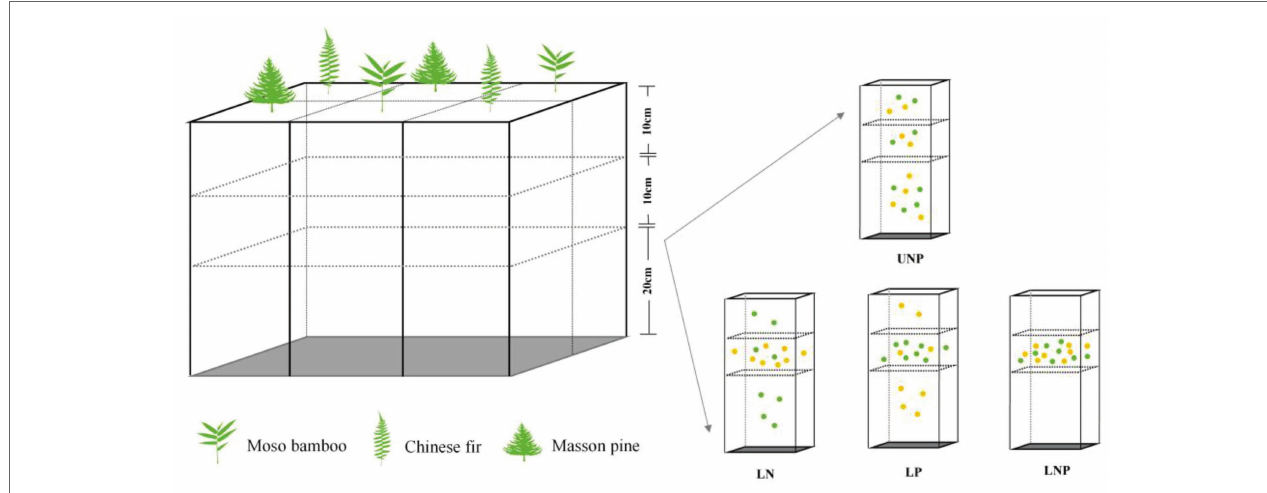
FIGURE 1 | Schematic drawing of the container and the experimental treatments. Each treatment was repeated six times (i.e., container), and two seedlings of each species were randomly planted into each container with two replicates. Each yellow point denotes 0.25 g N, and each green point denotes 0.25 g P. UNP, uniform N plus P supply; LN, localized N supply; LP, localized P supply; and LNP, localized N plus P supply. The same